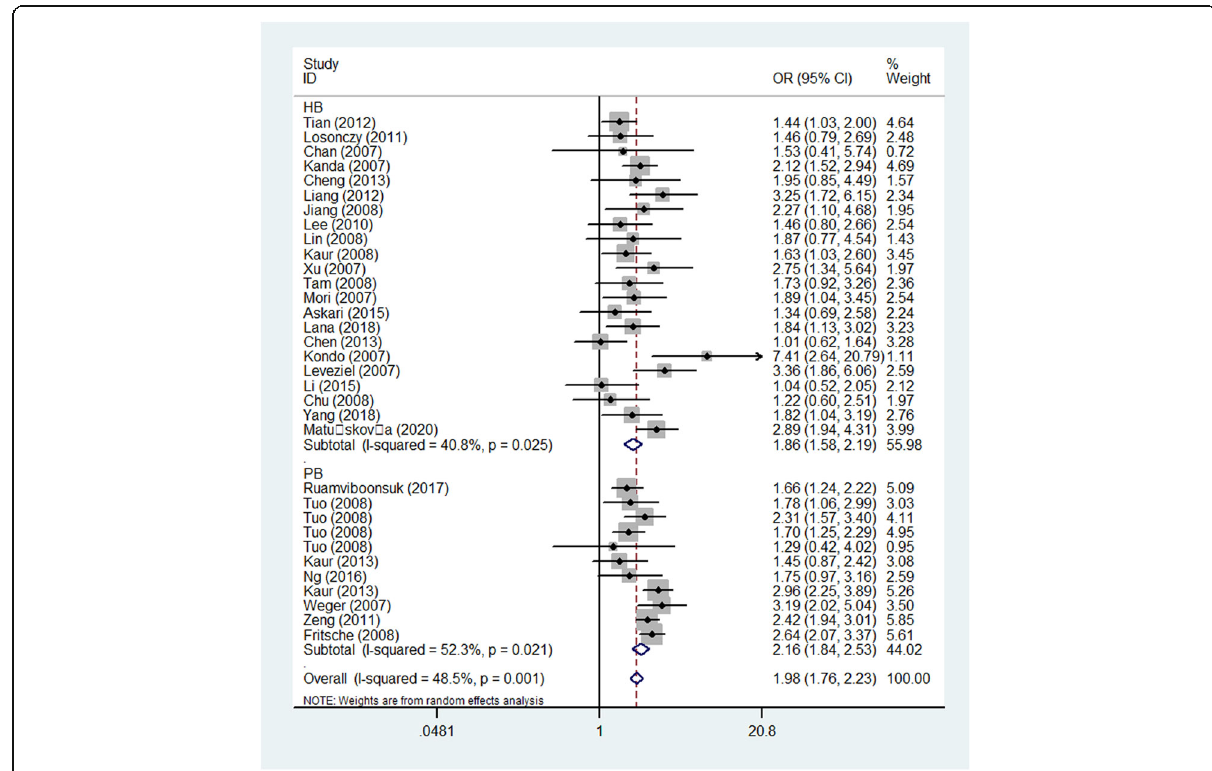
Fig. 5 Forest plot of AMD risk associated with HTRA1 gene rs11200638 polymorphism (AG vs. GG) by source of control subgroup